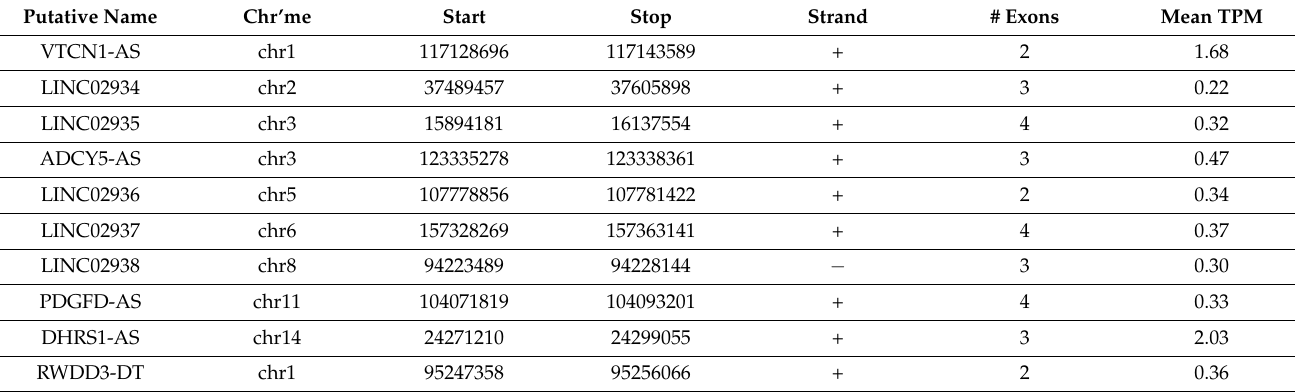
Table 1. Information on the 10 novel lncRNAs detected with our